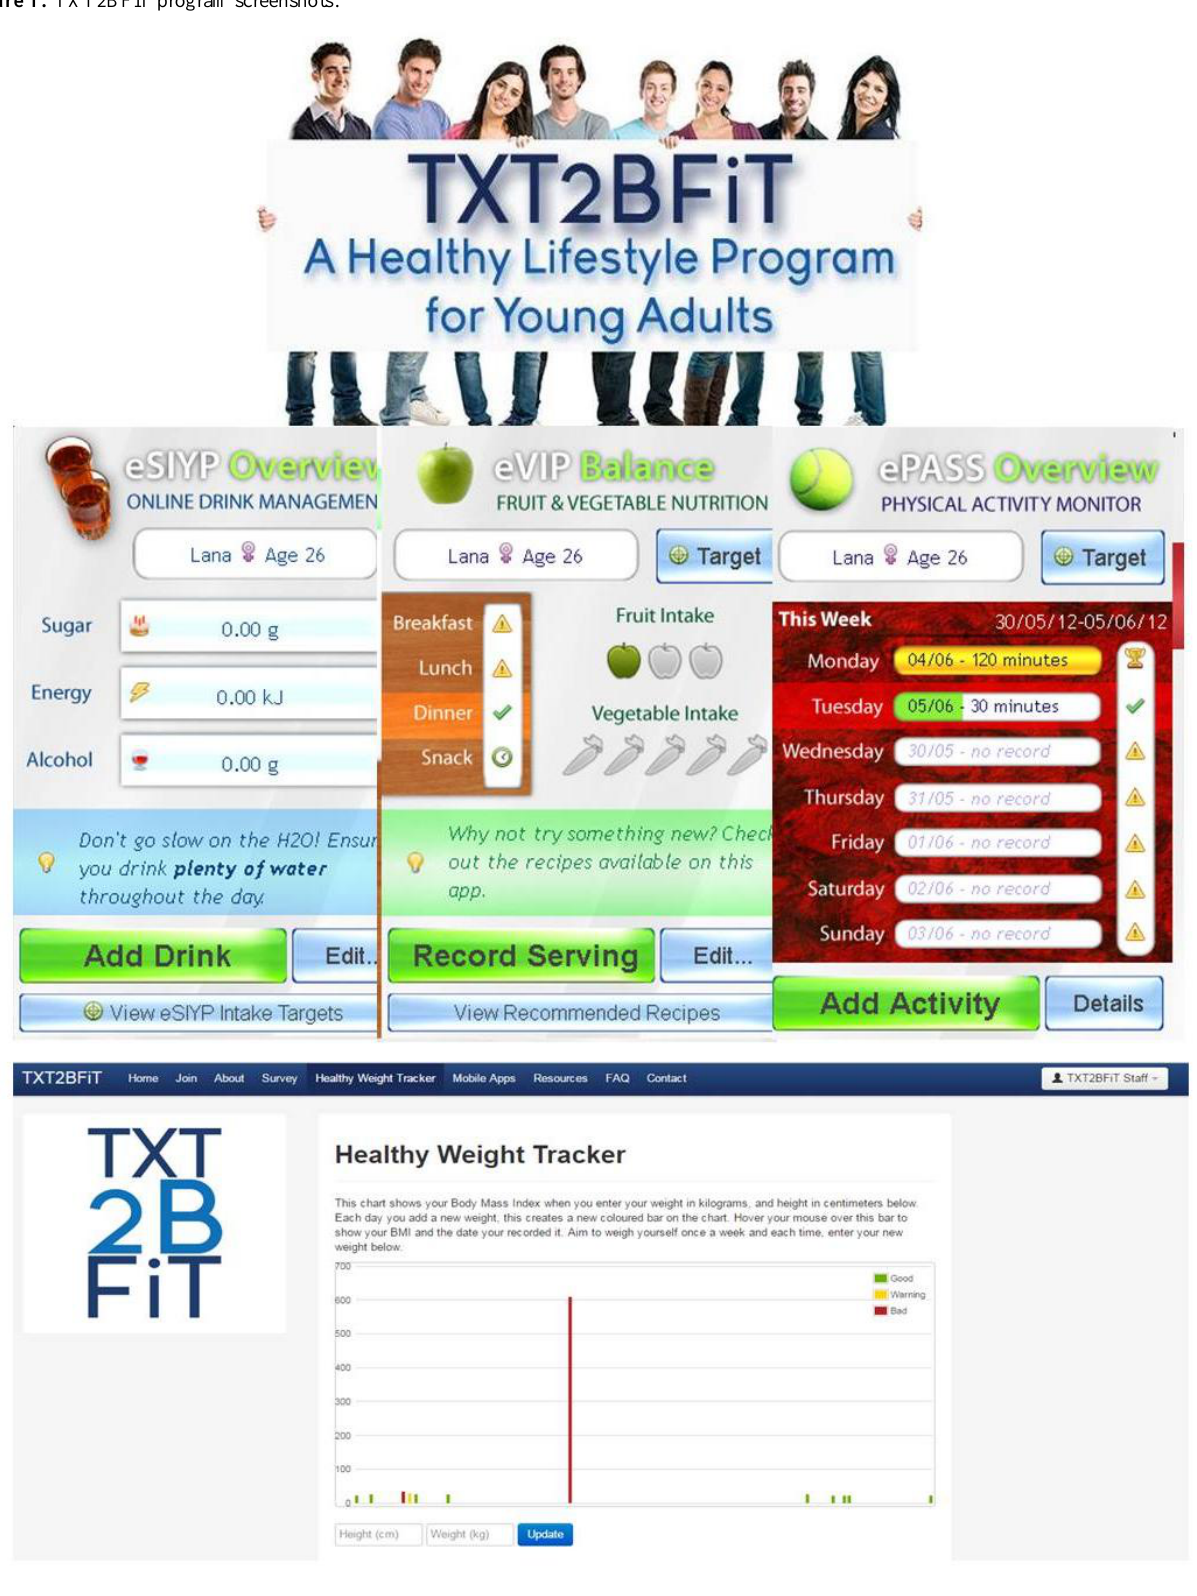
Figure 1. TXT2BFiT program